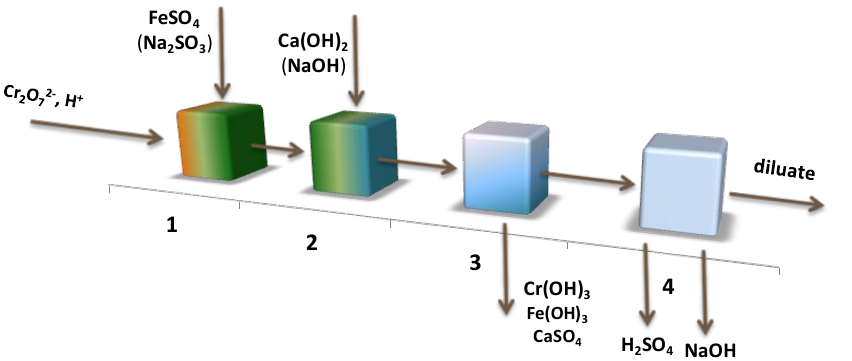
Figure 10. Scheme of the treatment of chromium-containing wastewater with the introduction of the electromembrane processing stage for the conversion of a salt solution. Designations are given in the text.